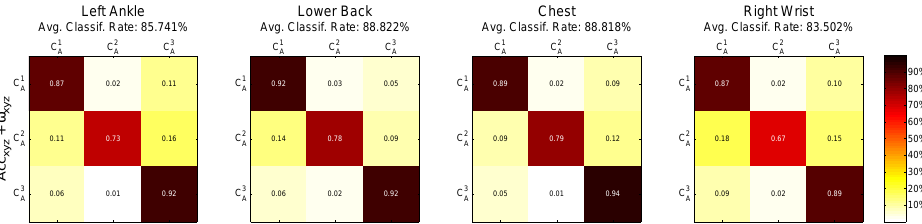
Figure 5. Confusion matrices of age classification computed with 10-fold cross-validation. Each column presents the sensor position (left to right): left ankle, lower back, chest and right wrist. 6D accelerations and angular velocities (50 features) were used for classification. C 1 C 2 : 40 ≤ age < 50; C 3 : age ≥ A A